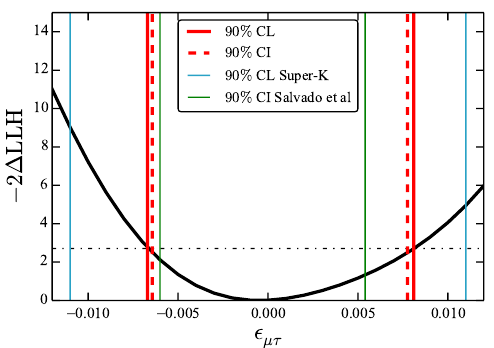
Figure 23.2: Bound on (cid:34) µτ from different analyses are shown: in blue the analysis by SuperKamiokande, in red the low energy IceCube DeepCore analysis and in